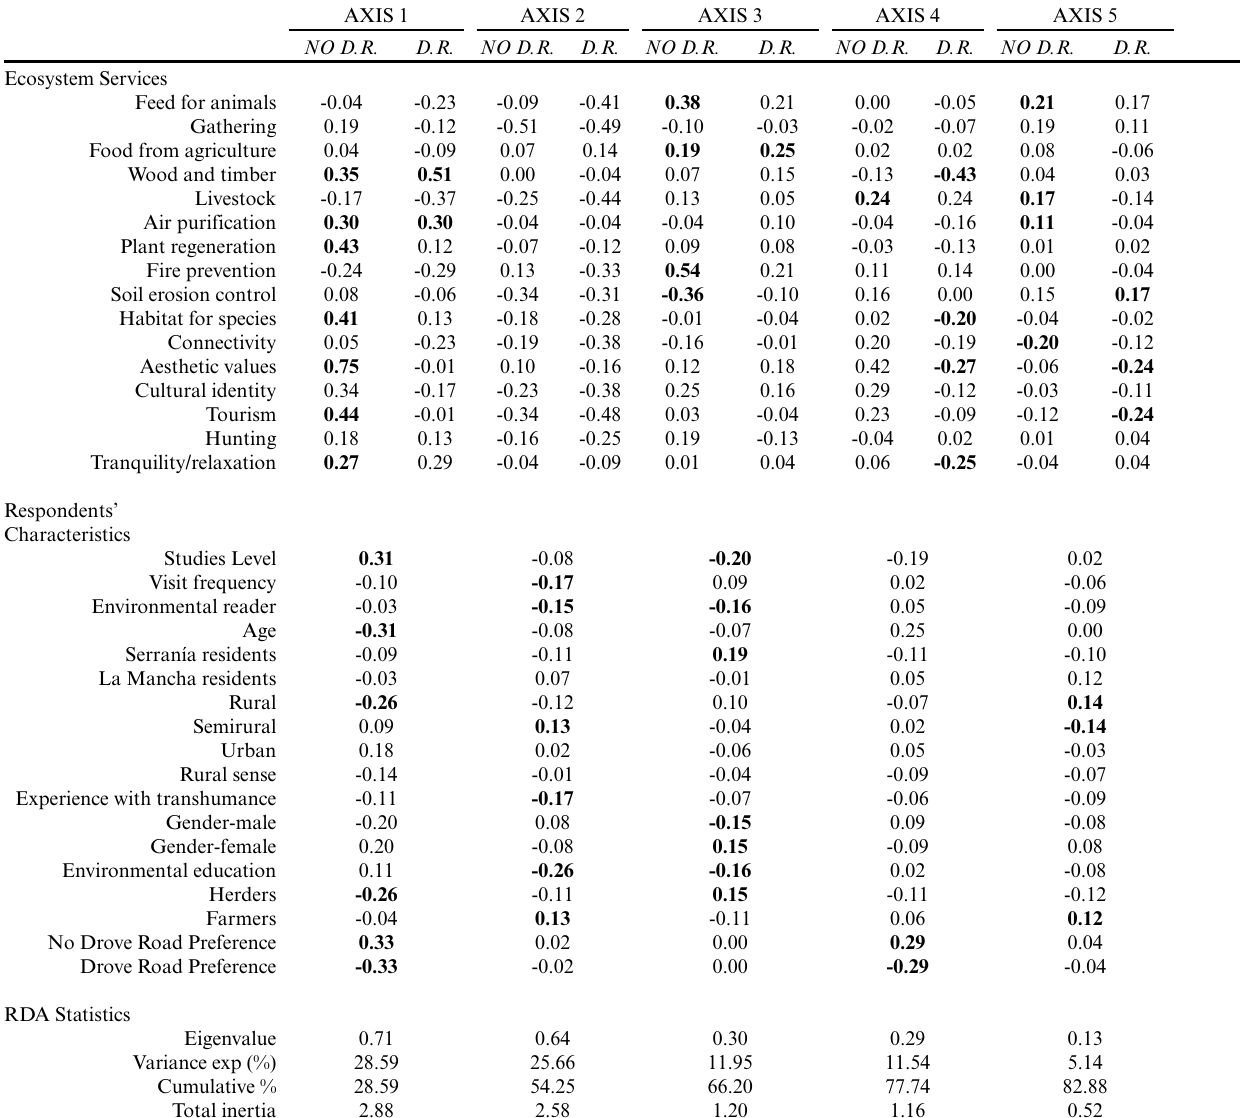
Table 3 . Redundancy analysis results for the pine forest landscape, showing the factor scores of ecosystem services and the variables related to the socioeconomic characteristics of the respondents. Eigenvalues, percentage of variance explained, cumulative percentage of variance explained, and inertia by axes (1–5) are also indicated. Bold values indicate the variables with the largest squared cosine in each of the